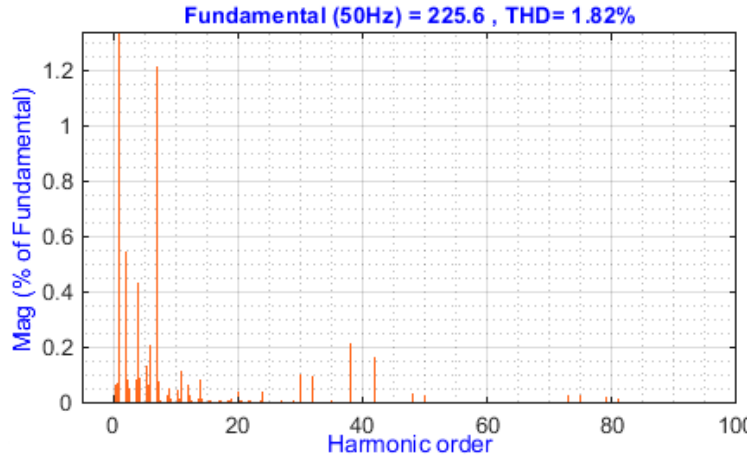
Figure 18. Total and individual harmonics level of the output current at PCC after filtering with low solar irradiation (600 W / m 2 ) . solar irradiation (600 W/m 2 ) .